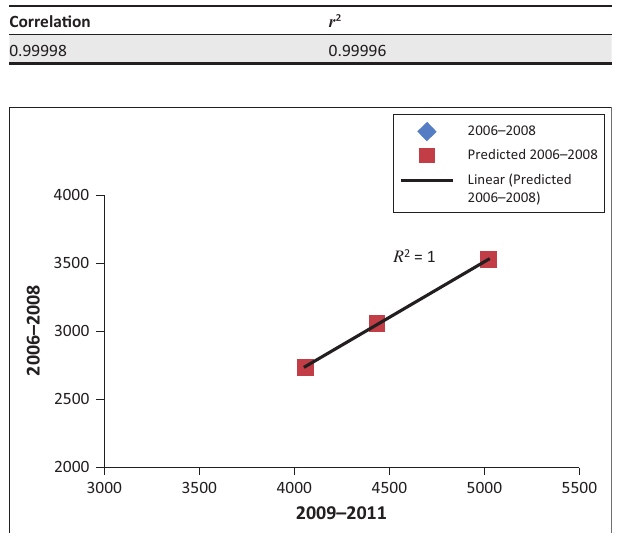
TABLE 11: Correlation and r 2 between cost to company mean of 2006–2008 and 2009–2011.